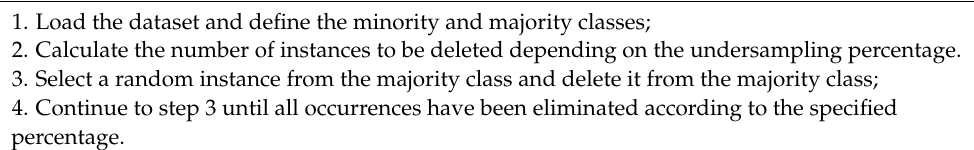
Algorithm 3: Random Undersampling (RUS)